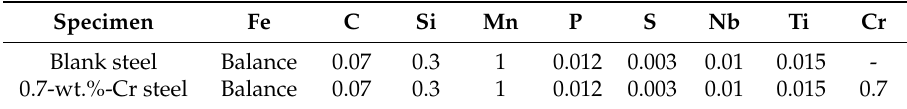
Table 3. Chemical compositions of low-alloy steels